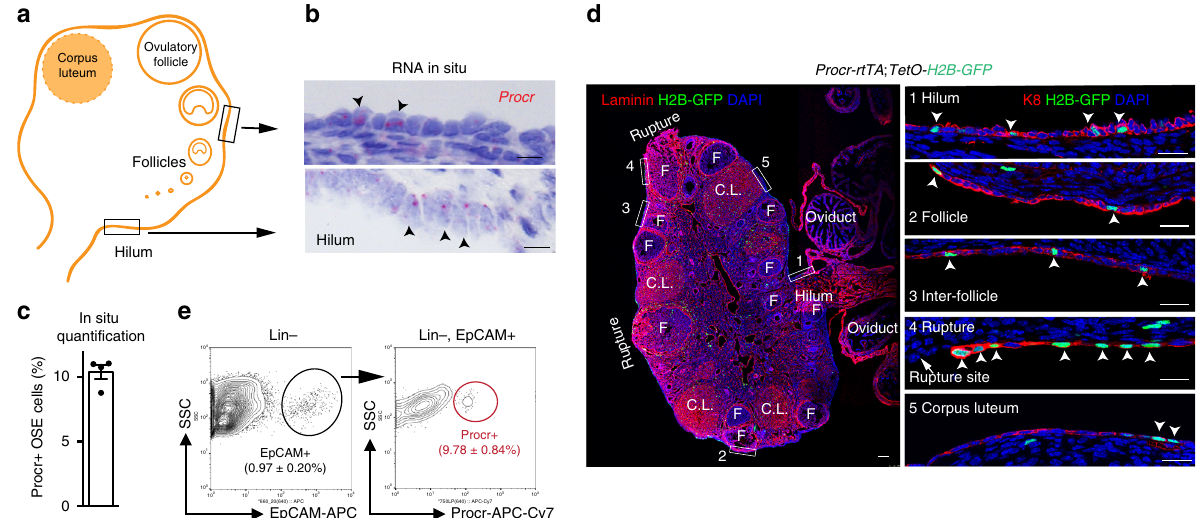
Fig. 1 A subpopulation of OSE cells express Procr. a A schematic diagram of the mouse ovary with various stages of follicles. b RNA in situ indicating the expression of Procr in the adult mouse OSE, in both the non-hilum region (upper panel) and hilum region (lower panel). n = 4 mice and 16 images. Scale bar, 10 μ m. c Procr + cells percentage in the OSE based on RNA in situ results. Data are pooled from four independent experiments and presented as mean ±s.e.m. d Procr-rtTA;TetO-H2B-GFP mice were fed with doxycycline for 2 days. Confocal image of an ovary section showing the expression of Procr by histone 2B-GFP (arrowheads) in different regions of the OSE (F, follicle; C.L., corpus luteum). n = 4 mice and 16 images. Scale bars, 100 μ m in full ovary view and 20 μ m in zoom in view. e FACS analysis of adult mice OSE with EpCAM and Procr. The percentages of total OSE cells (Lin − , EpCAM + ) and Procr + OSE cells (Lin − , EpCAM + , Procr + ) are as indicated. Data are pooled from four independent experiments and presented as